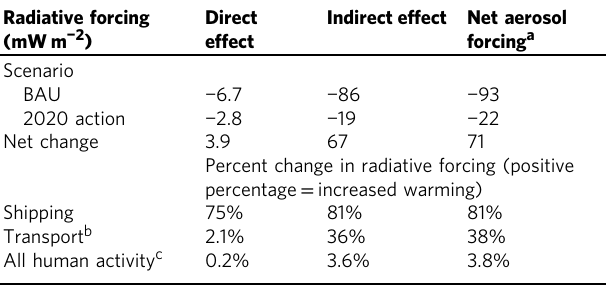
Table 3 Summary of change in radiative forcing due